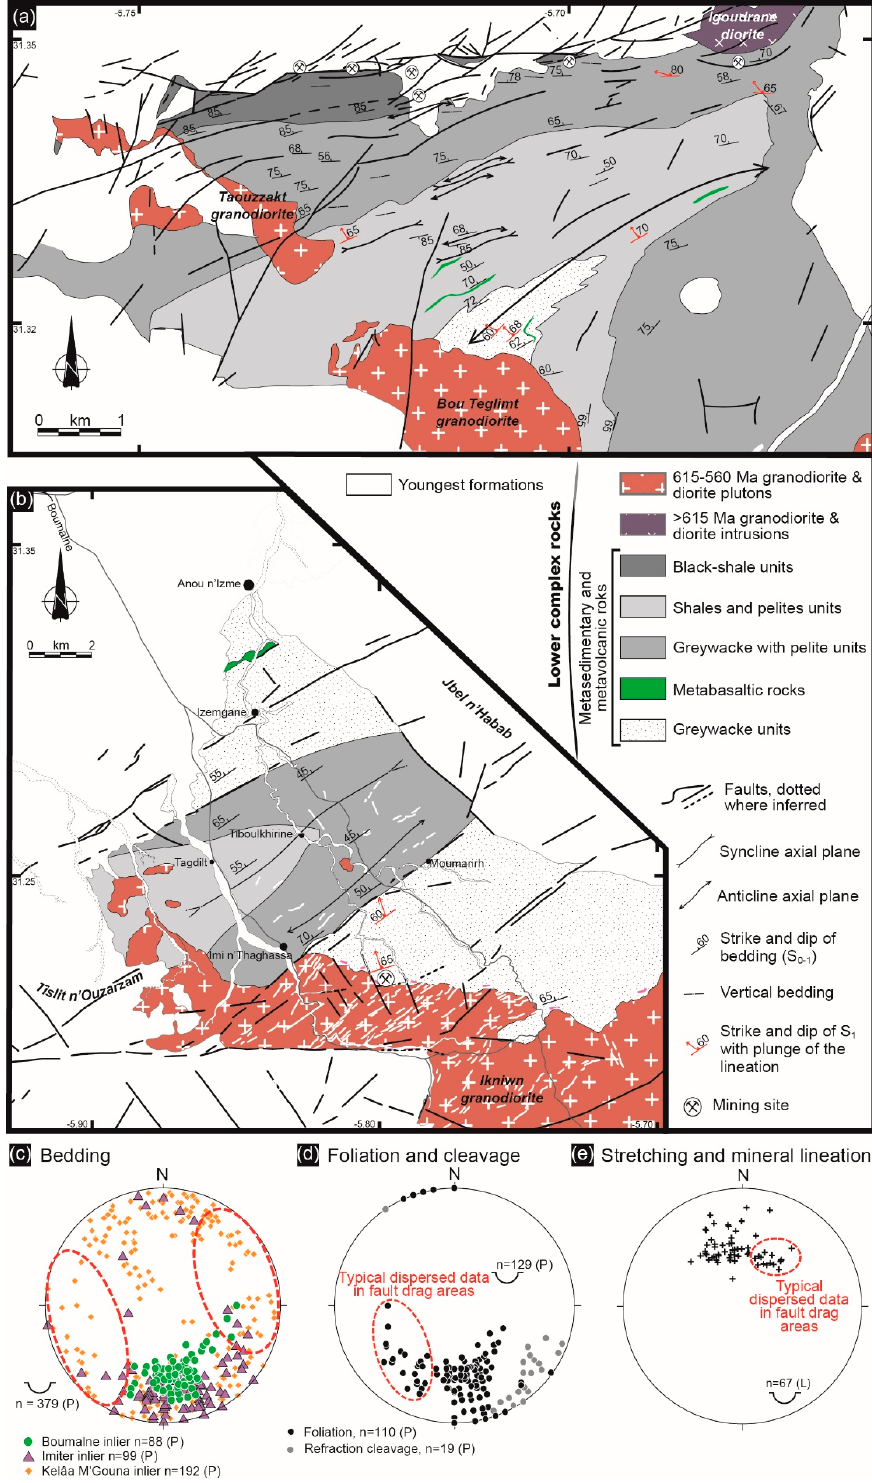
Figure 3. Structural maps of the ( a ) Imiter inlier modified from SMI (Société Métallurgique d ʹ Imiter) data and Ighid et al. [121] and ( b ) Boumalne inlier (from Tuduri et al. [48]). Note that metabasaltic rocks with pilloid structures have never been observed in the Imiter inlier. Sills have been described and discussed as possibly syn-sedimentary in origin [100]. Stereoplots of structural orientation data: ( c ) bedding, ( d ) foliation and refraction cleavage, and ( e ) lineation. Bedding data are from the Qal’at MGouna, Boumalne and Imiter Lower Complex inliers whereas foliation, refraction cleavage and